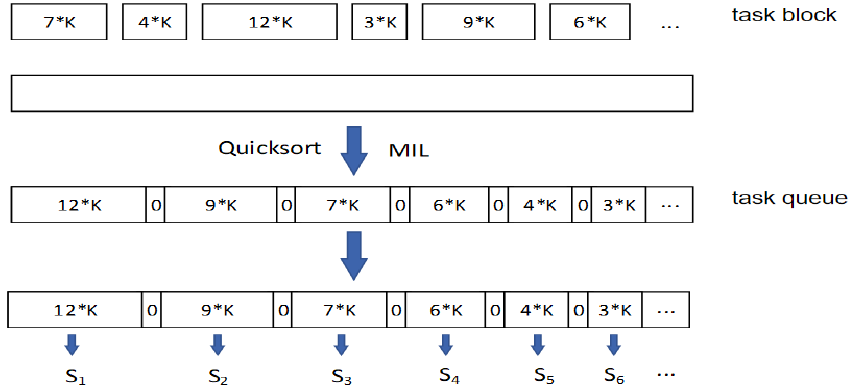
Figure 4. The illustration about the constructed order of tasks.